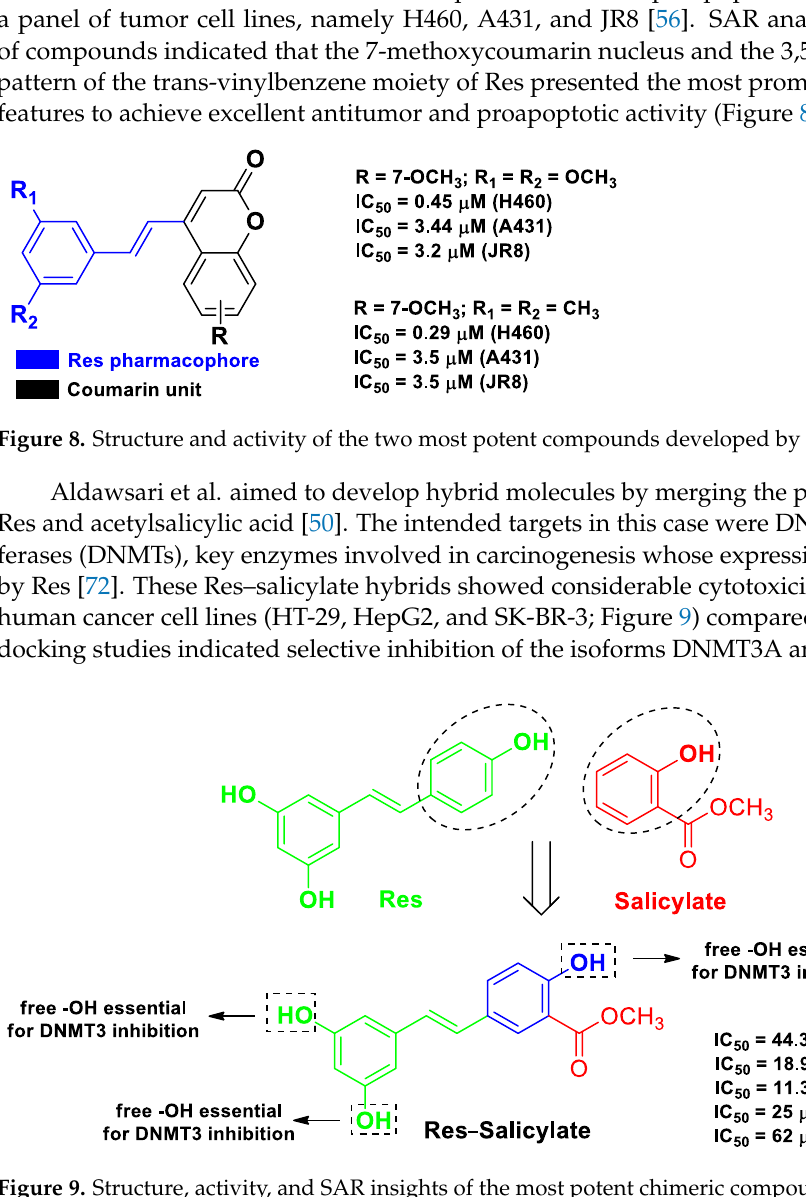
Figure 9. Structure, activity, and SAR insights of the most potent chimeric compound developed by Aldawsari et al. [50].